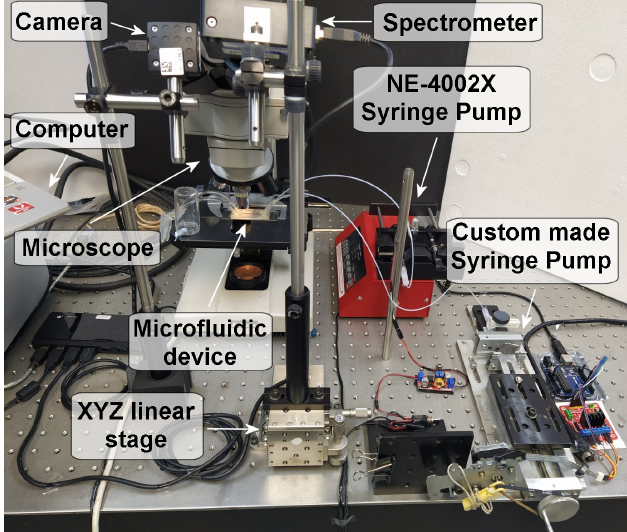
Figure 3. Optofluidic